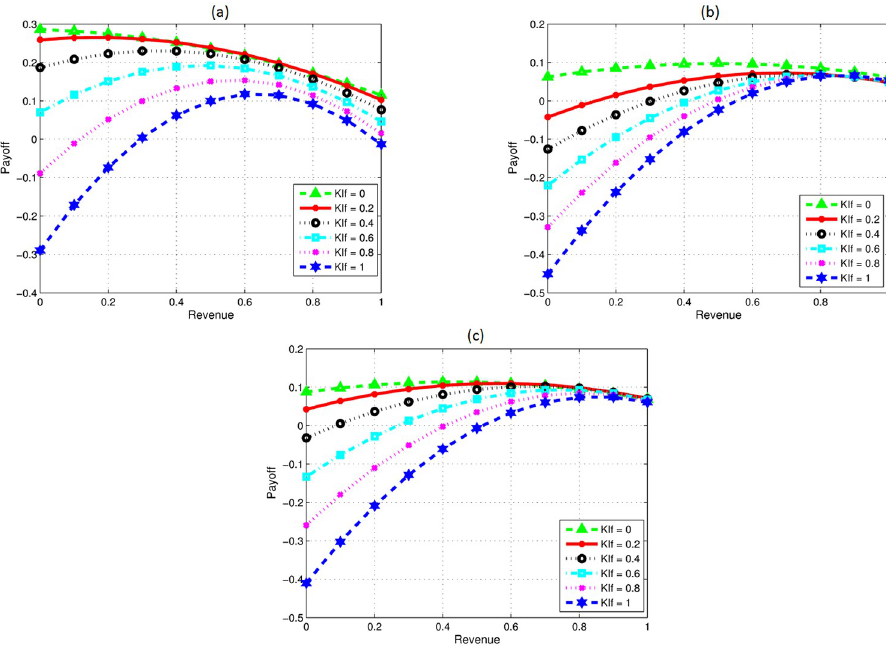
Fig 3. Impact of varying knowledge investment by F. (a) P high F varying investment. (b) High initial DC and technical skills for F. (c) DCDR for P high, F high technical skills.